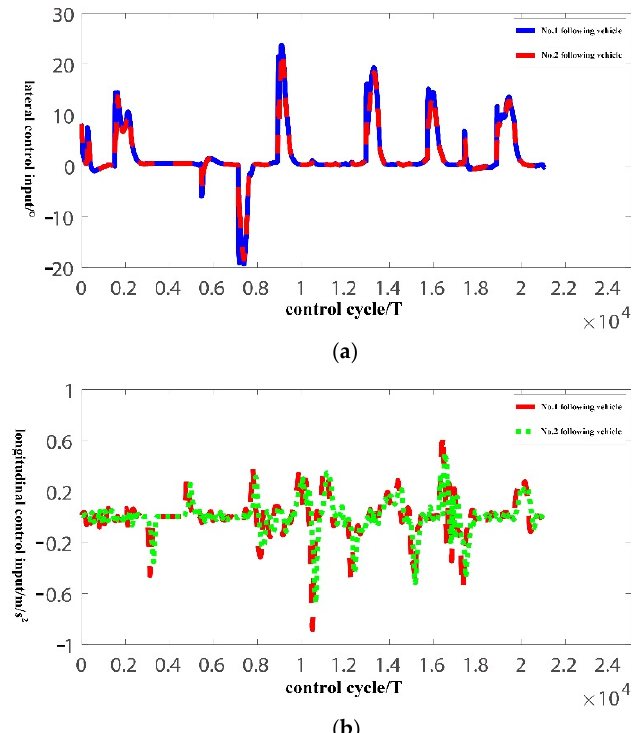
Figure 11. Lateral and longitudinal error curve of bus platoon. ( a ) Platoon lateral control input; ( b ) Platoon longitudinal control input.